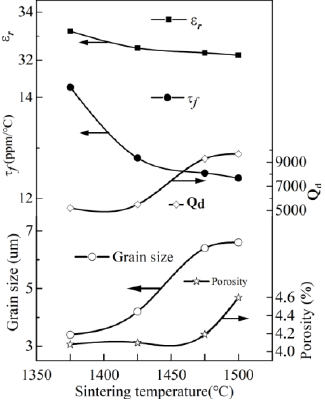
Figure 1. Microwave dielectric properties of 0.774Ba(Zn 1/3 Nb 2/3 )O 3 -0.226BaSnO 3 sintered at different temperatures for 6 h; data from Ref. [53].